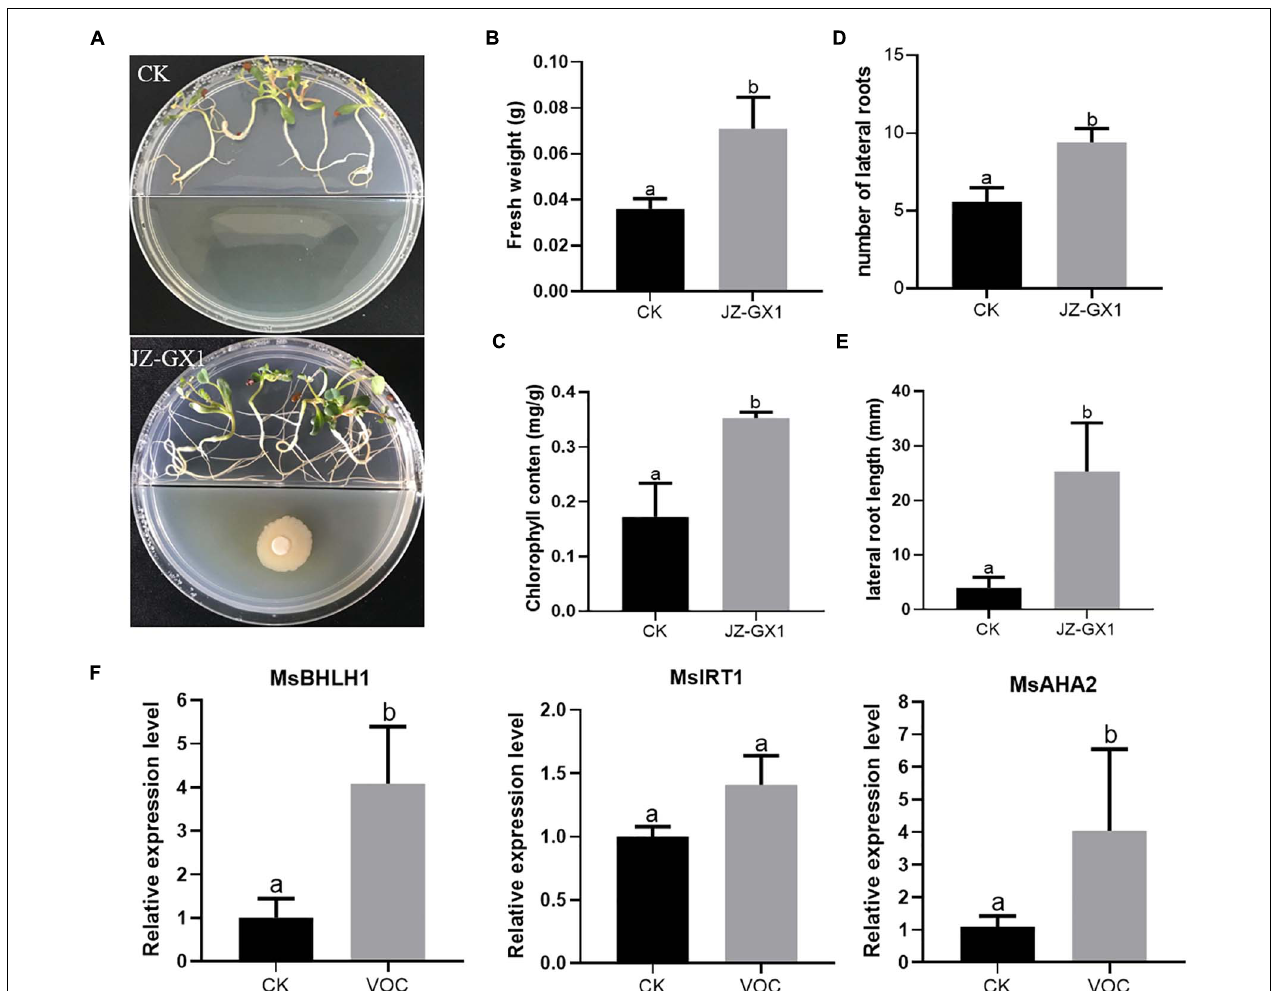
FIGURE 6 | Effect of VOCs from Rahnella aquatilis JZ-GX1 on the growth of Medicago sativa under iron-deficient conditions. (A) Plant phenotype, (B) fresh weight, (C) chlorophyll content, (D) lateral root number, (E) lateral root length, and (F) relative expression of MsBHLH1 , MsIRT1 , and MsAHA2 in roots of M. sativa seedlings that were CK (control) or treated with VOCs from R. aquatilis JZ-GX1 (VOC). One-way ANOVA was performed, and Duncan’s post hoc test was applied. Different letters indicate statistically significant differences ( p < 0.05) among